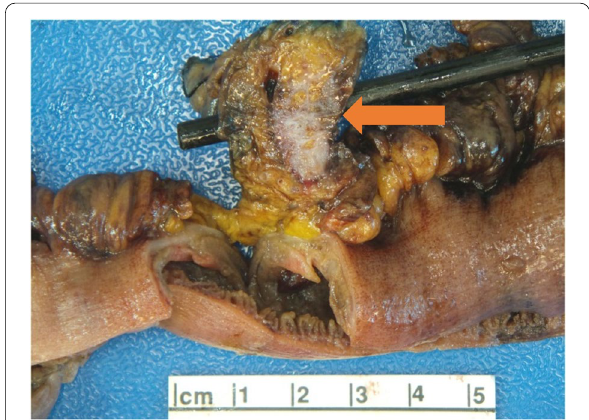
Fig. 2 Gross examination. An ill-defined, tan-white rubbery nodule is present in the pericolonic adipose tissue (orange arrow)